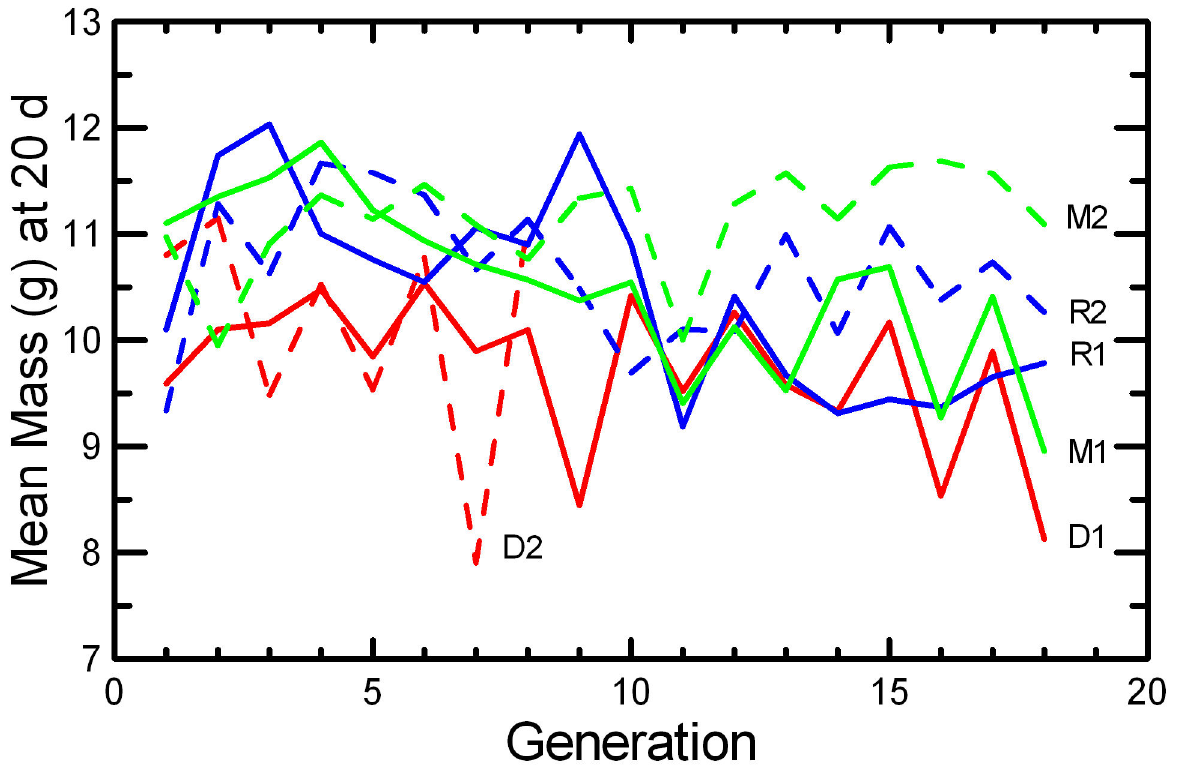
Figure 9. Weaning Mass. The mean mass (g) of pups weaned for those pairs that produced at least one litter is given for the two replicates of RAN (blue), MK (green), and DOC (red) experimental